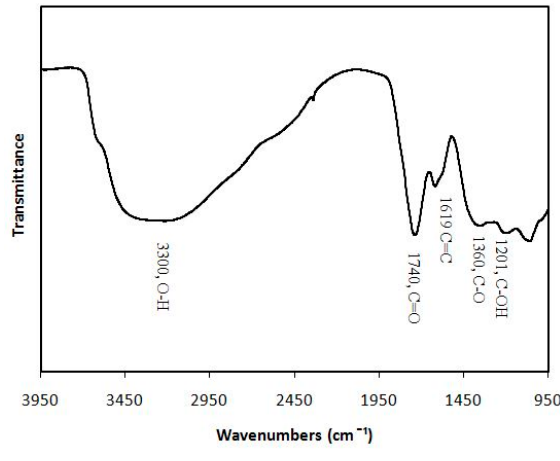
Figure A1. Fourier-transform infrared spectroscopy (FTIR) analysis of GONPs.